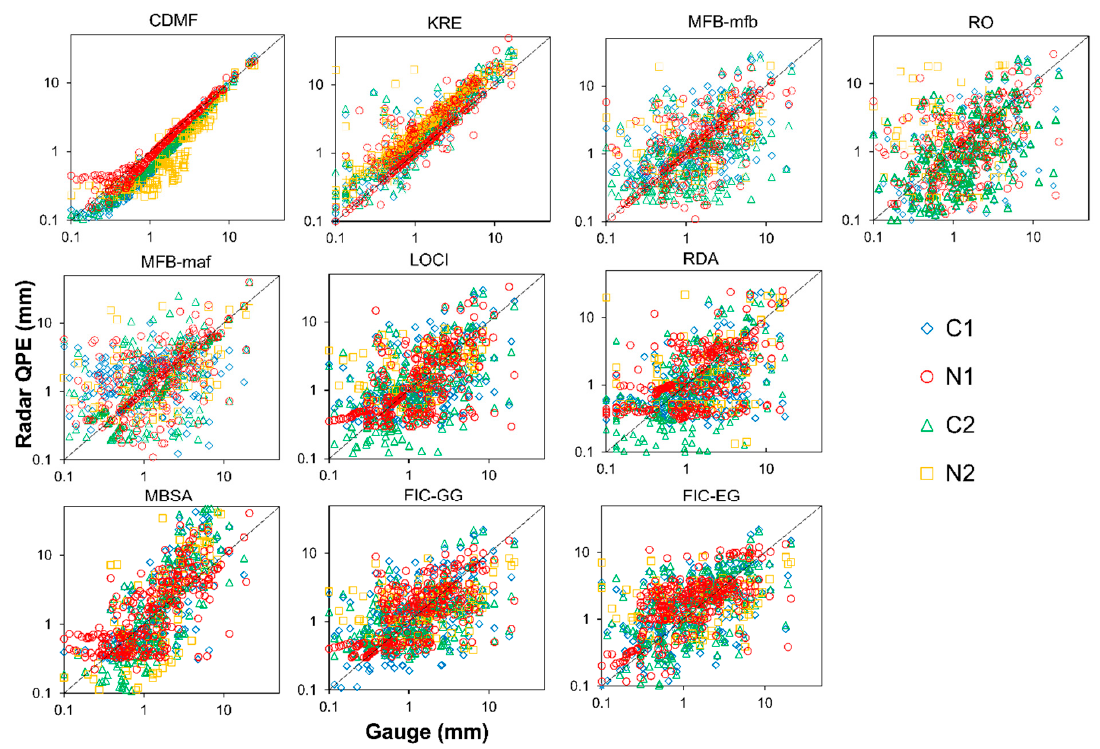
Figure 5. Scatterplots of radar quantitative precipitation estimate (QPE) hourly accumulations as a function of the hourly gauge accumulations before and after radar-gauge merging (Note: both horizontal and vertical axes are in log scale).